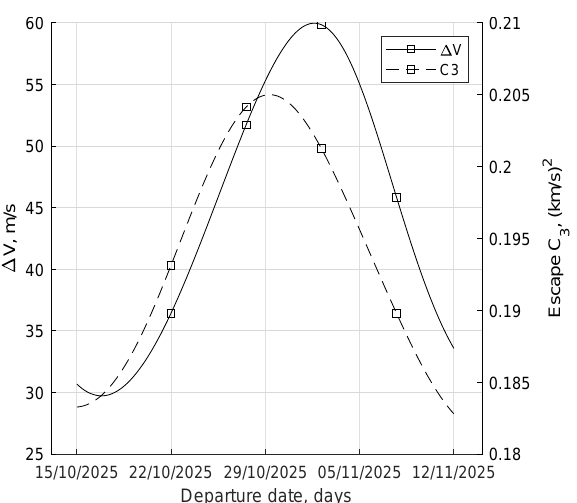
Figure 7. Influence of departure date to escape from SEL2—fixed t f = 90 days, free C 3